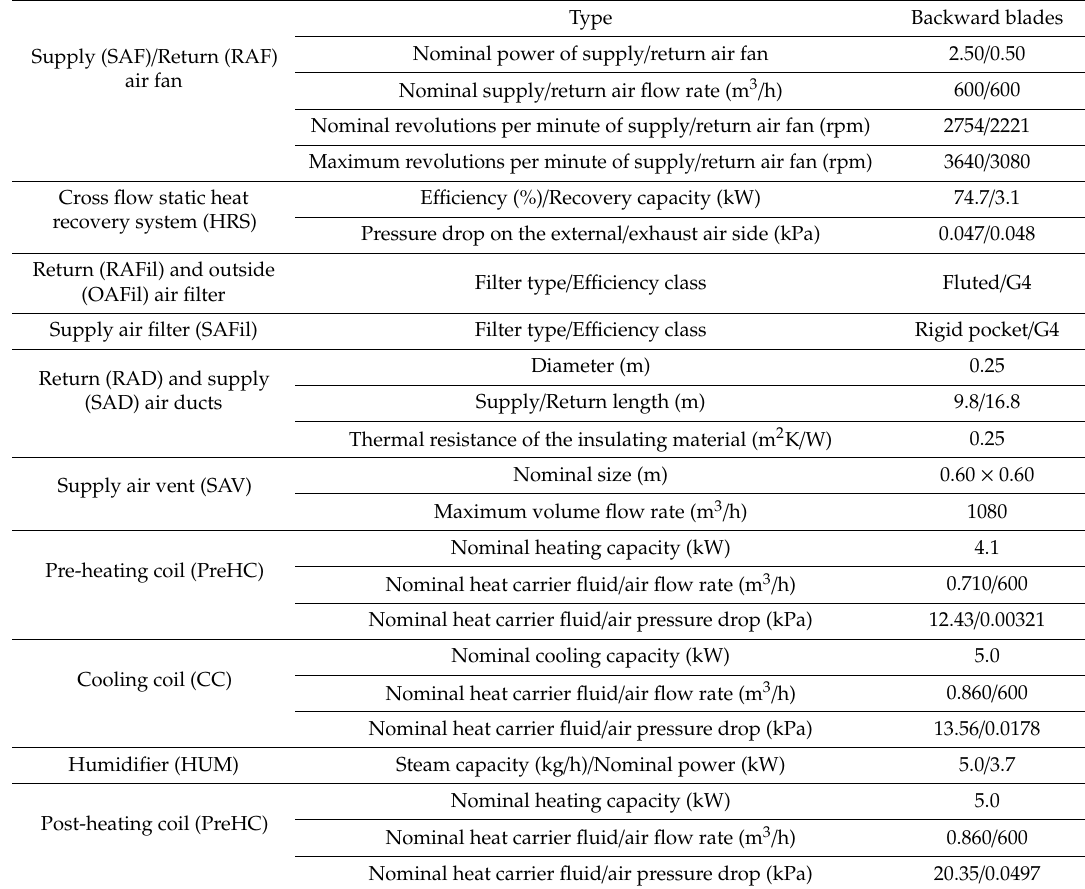
Table 2. Characteristics of main AHU